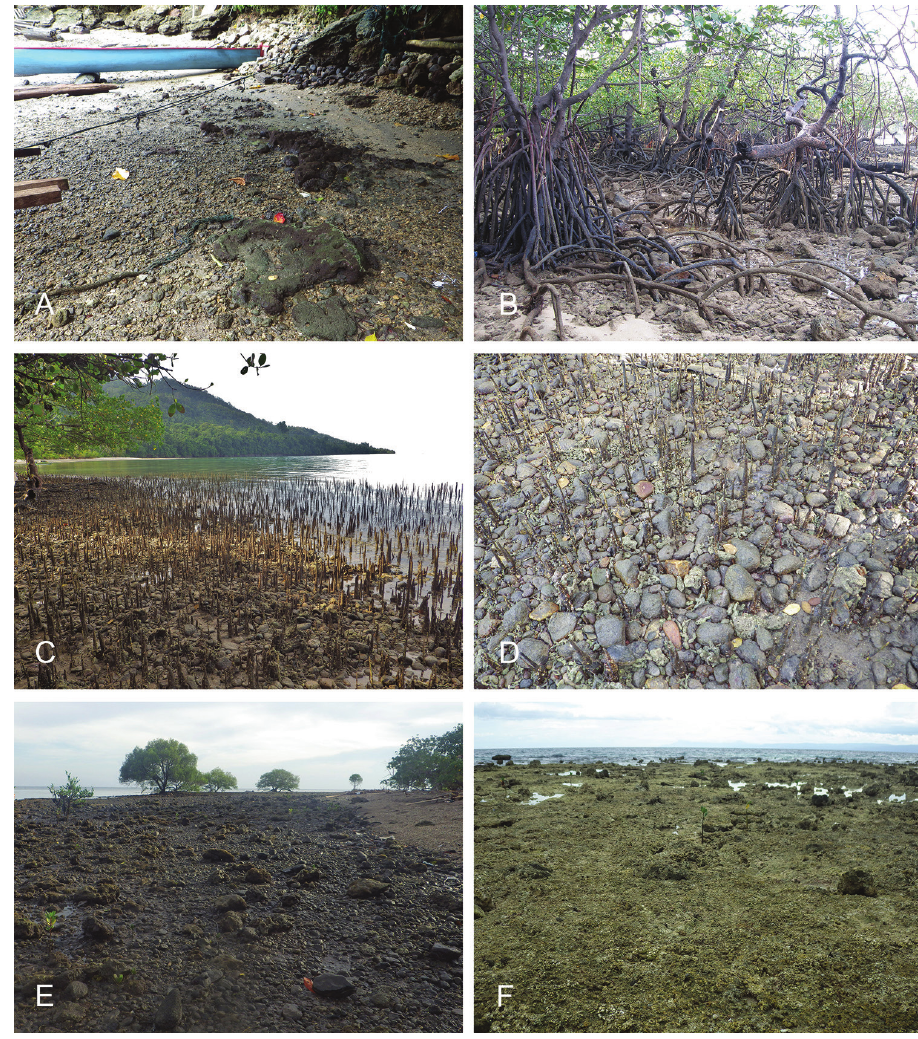
Figure 29. Habitats, Wallaconchis nangkauriense . A Indonesia, Sulawesi, sand, rocks, pieces of wood be- hind narrow coastal mangrove (st 85) B India, Andaman Islands, Burman Nala, slugs were on the stilt roots (st 53) C Indonesia, Ambon, Haruku Island, narrow mangrove of Sonneratia trees on rocky beach (st 127) D Close up (same locality as C) E Indonesia, Bali, Pemuteran, Labuhan Lalang Harbor, coral rubble, rocks and a few Avicennia (st 157) F Philippines, Bohol, Maribojoc, coral rubble of uplifted coral reef (st 191).